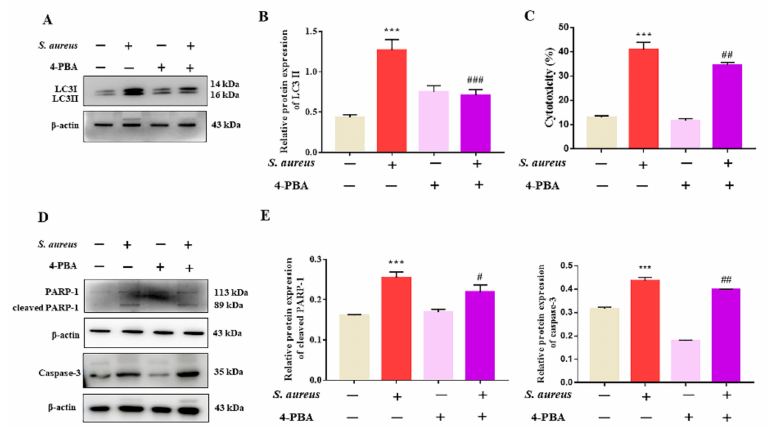
Figure 5. 4-PBA attenuated S. aureus -induced gEECs autophagy and apoptosis. ( A , D ) gEECs were pretreated with 4-PBA (1 mM) and infected with S. aureus (10 MOI). The protein levels of LC3II, caspase-3, and cleaved-PARP-1 were quantified by Western blot. ( B , E ) The expressions of LC3II, caspase-3, and cleaved-PARP-1 were quantified by densitometry, and were normalized to β -actin. ( C ) LDH release was measured using a cytotoxicity LDH assay kit. Each experiment was repeated three times. *** p < 0.001 vs. the mock group, # p < 0.05, ## p < 0.01, and ### p < 0.001 vs. the S. aureus